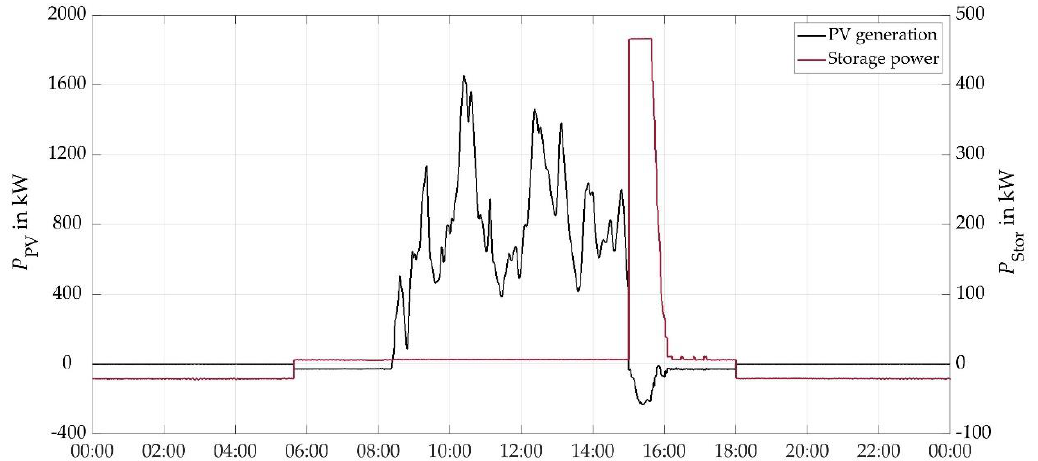
Figure13. Figure 13. Representation of the BES operation to cover the farm’s demand during the night (19 October 2015).